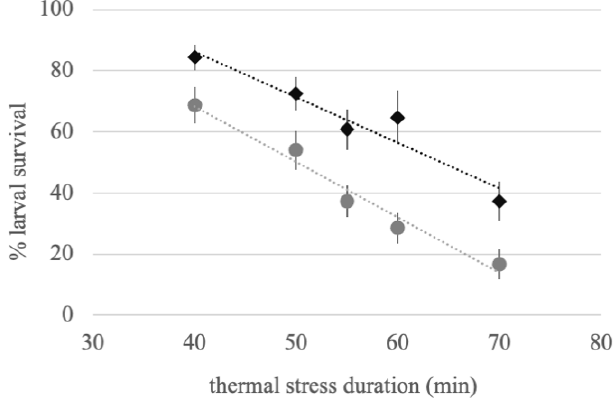
Figure 2. Effect of thermal stress on the larval survival of insecticide-resistant and -susceptible Aedes aegypti strains. Percentage of larvae still alive 24 h post-treatment following a 42 °C thermal stress of variable duration. The grey circles represent Vergel-susceptible (Vs), and the black diamonds represent Vergel-resistant (Vr). Bars represent S.E.M.